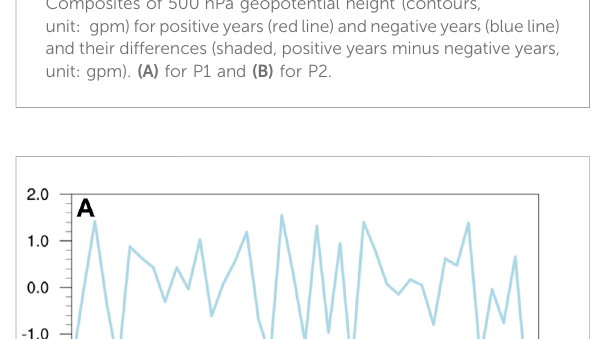
FIGURE 8 Composites of 500 hPa geopotential height (contours, unit : gpm)forpositiveyears(redline)andnegativeyears(blueline) and their differences (shaded, positive years minus negative years, unit : gpm). (A) for P1 and (B) for